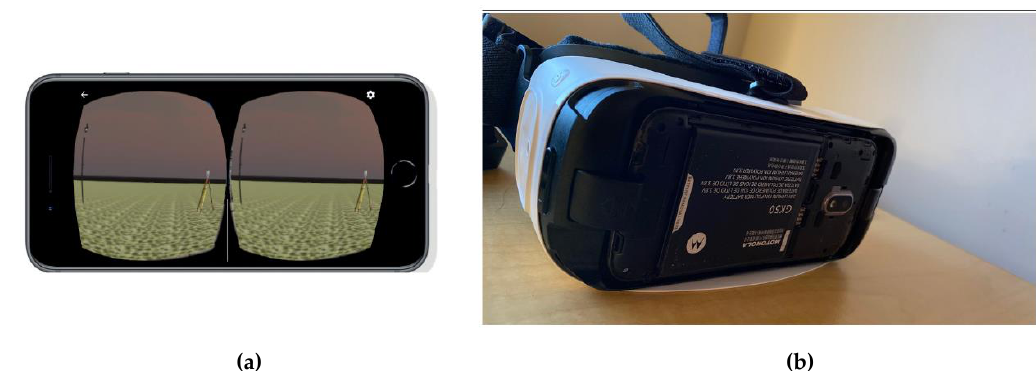
Figure 6. ( a ): a demo of an implemented VR application on an Android smartphone. ( b ): a view of the smartphone inside the Samsung VR goggles.